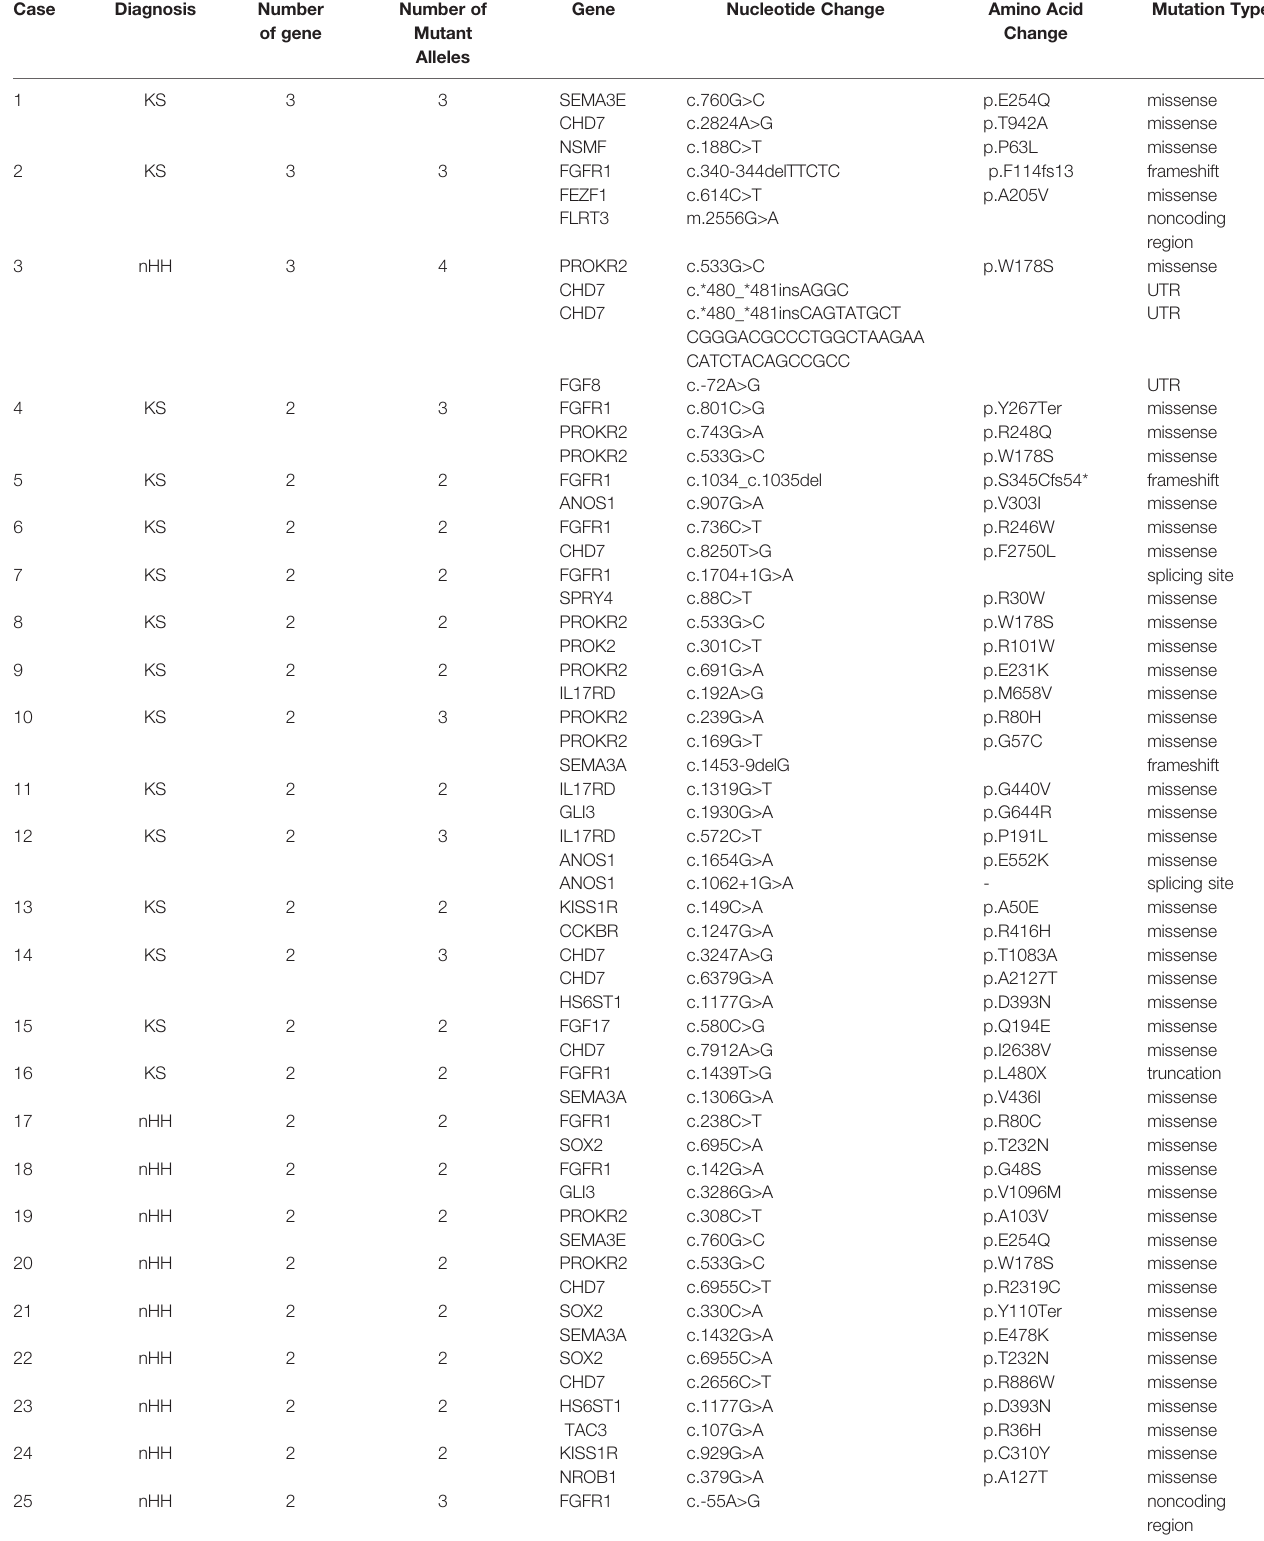
TABLE 3 | Oligogenic mutations of 26